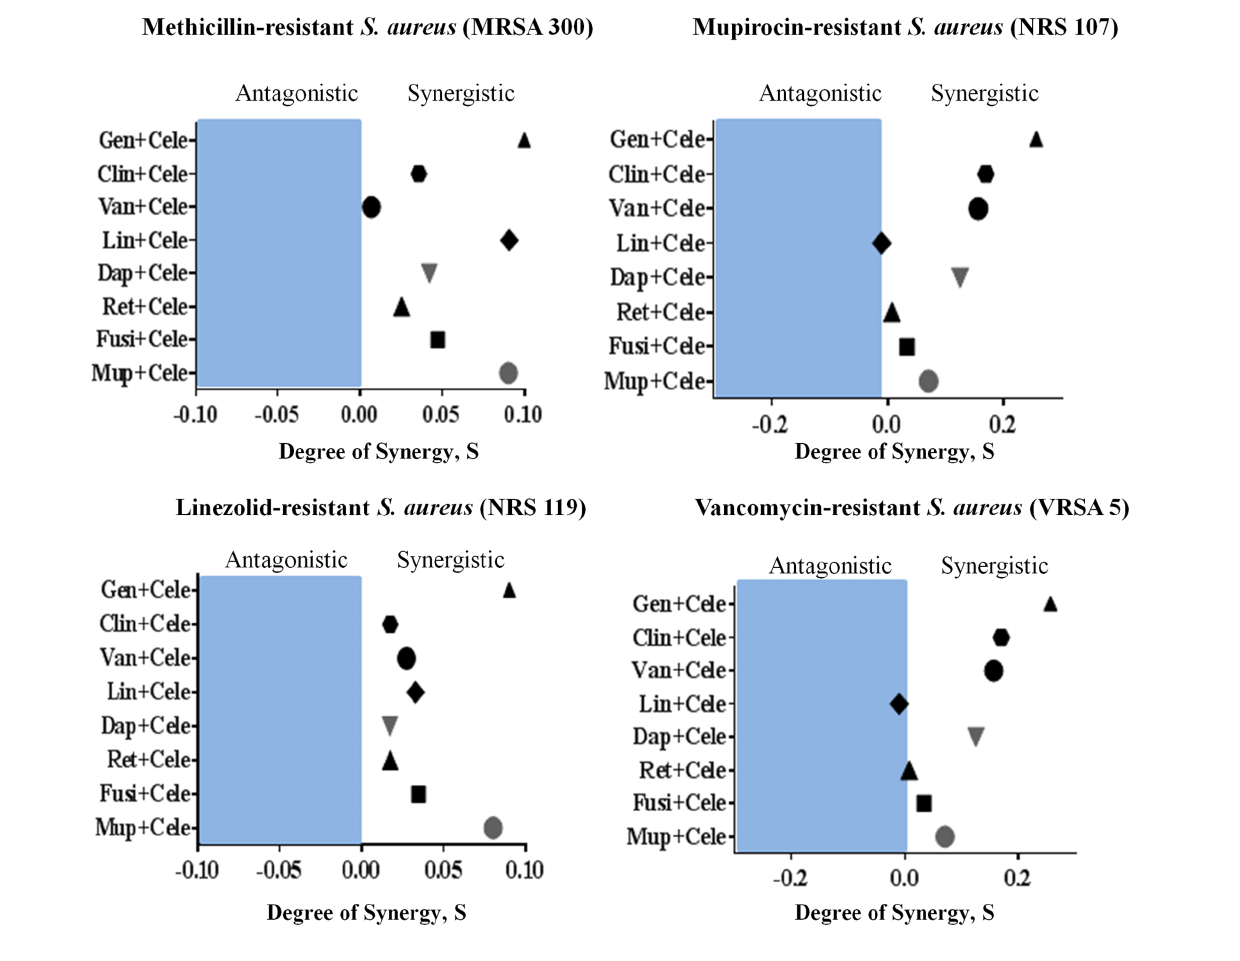
FIGURE 6 | Synergistic activity of celecoxib with topical and systemic antimicrobials. The Bliss Independence Model confirms a synergistic effect between celecoxib and conventional antimicrobials against various drug-resistant strains of S. aureus (MRSA300, NRS119, NRS107, and VRSA5).